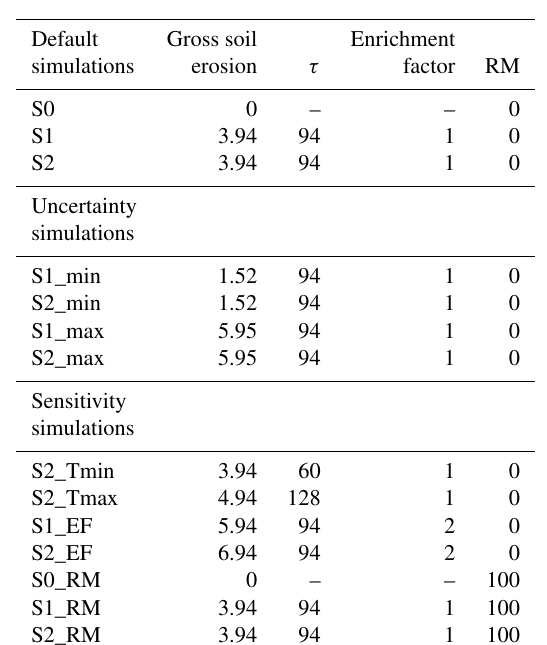
Table 2. Model simulations, with changes to the basin average gross soil erosion rate (tha − 1 yr − 1 ) , the basin average sediment residence time τ (years), the enrichment factor, and the crop residue harvest intensity RM